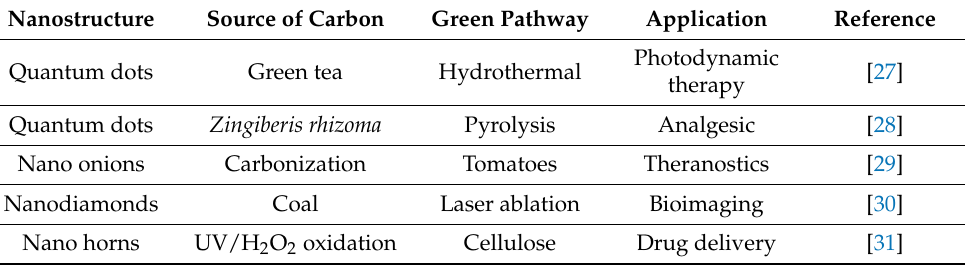
Table 1. Green routes for the synthesis of carbon